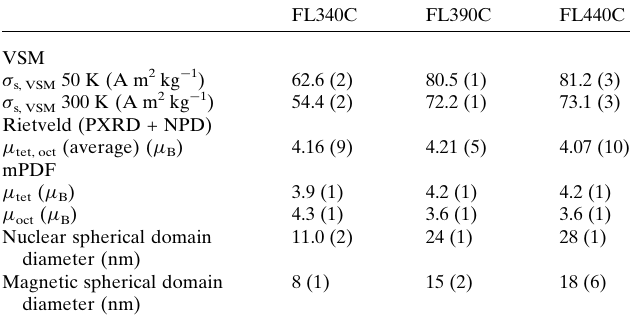
Table 3 Macroscopic magnetic properties measured by a VSM, and refined mPDF parameters for the magnetic structure.